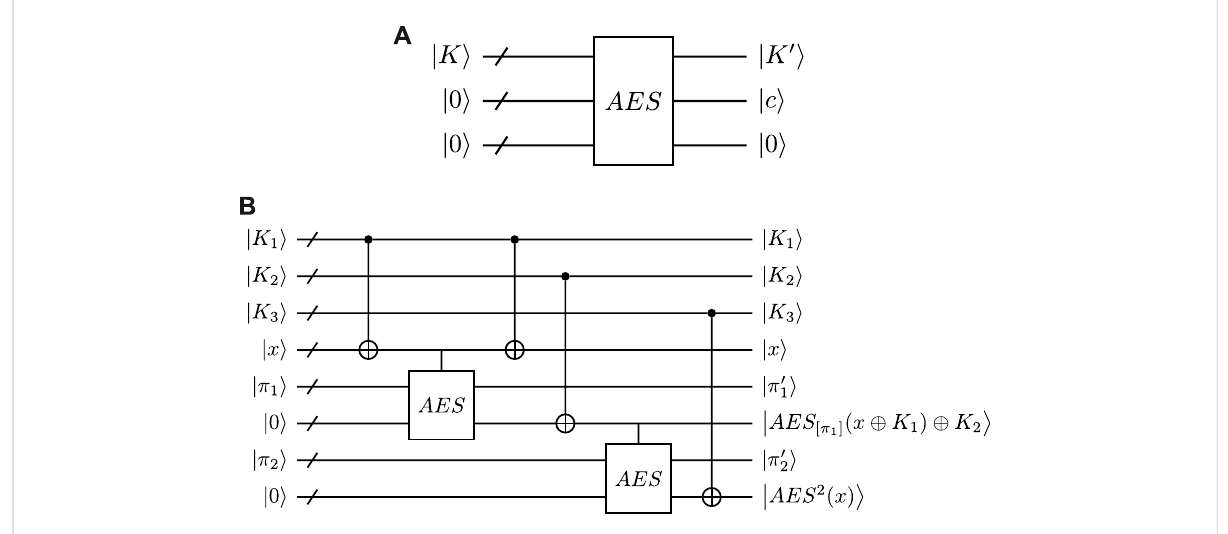
FIGURE 5 Quantumcircuitof (A) AES,wheretheboxofAESmeansthequantumcircuitofAES-128inRef.[35], K ′ isthesubkeyofthe10throundinAESand c istheciphertext; (B) AES 2 ,where thevertical line abovetheAES box indicatesthat 128 × 2CNOT gatesare performed insteadof 128× 2NOT gates in the quantum circuit of AES-128. The ancilla qubits and unused outputs are not